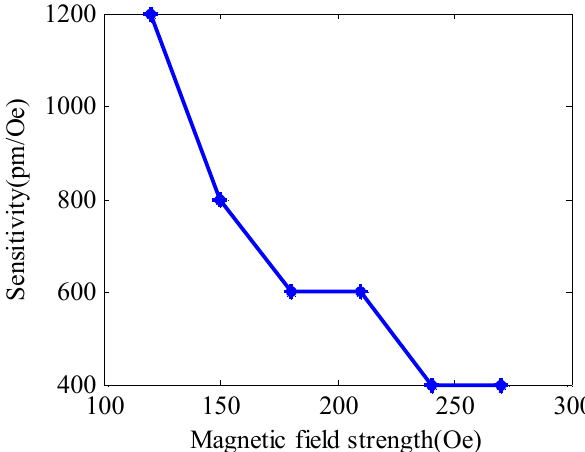
Figure 10. The sensitivity of the magnetic field sensor.